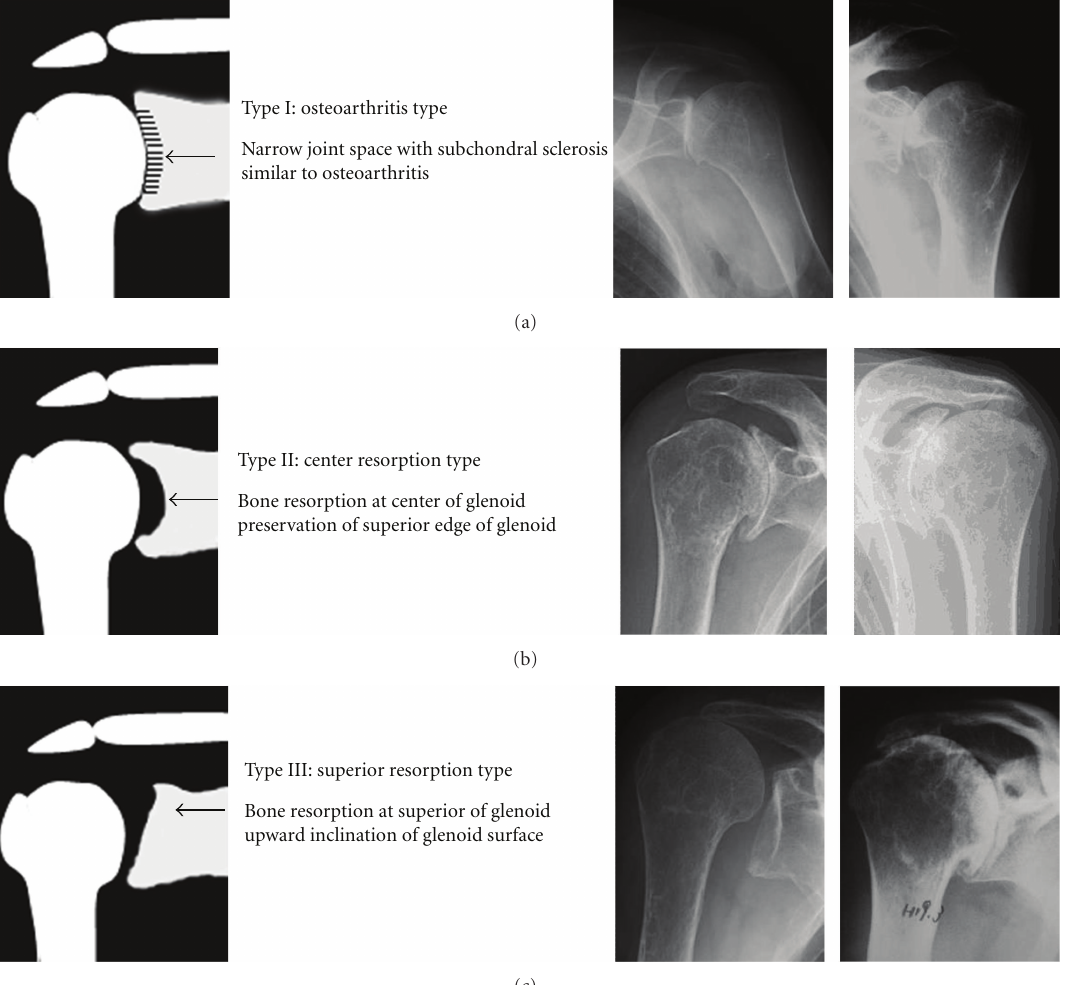
Figure 3: The characteristic changes in shape of the glenoid fossa of RA patients using radiological examinations in the coronal plane.